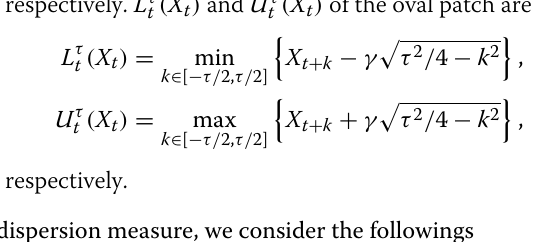
Fig. 3 Patches with rectangle shape P τ t patches, t i = 4,5,6. a τ = 4, b τ = 8, and c τ =